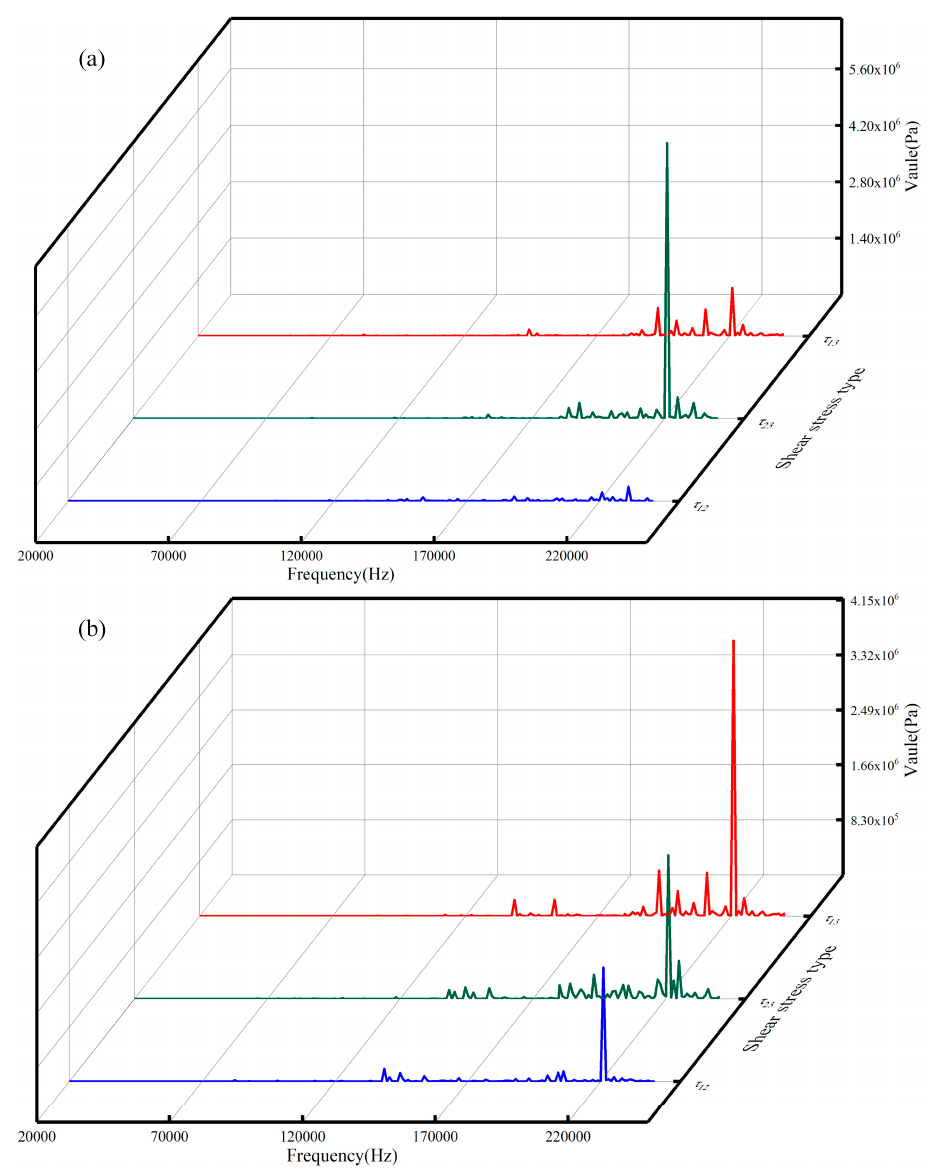
Figure 7. Shear stress amplitude-frequency curves of node: ( a ) node A (edge point); ( b ) node B (middle point).